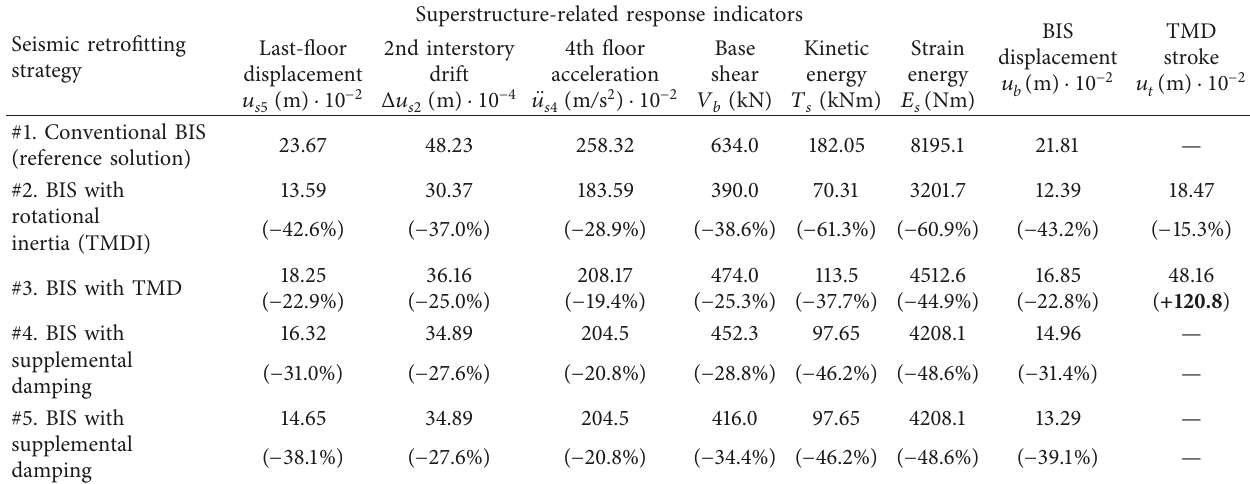
Table 4: List of results considering average MAX values of response indicators (Monte Carlo method with 100 artificial samples). Seismic retrofitting